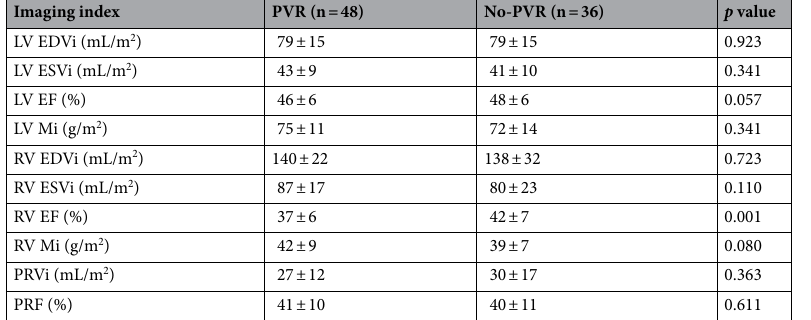
Table 2. Summary imaging indices grouped by PVR status. Data are reported as mean ± standard deviation. EDVi End-diastolic volume index, EF Ejection fraction, ESVi End-systolic volume index, LV Left ventricular,